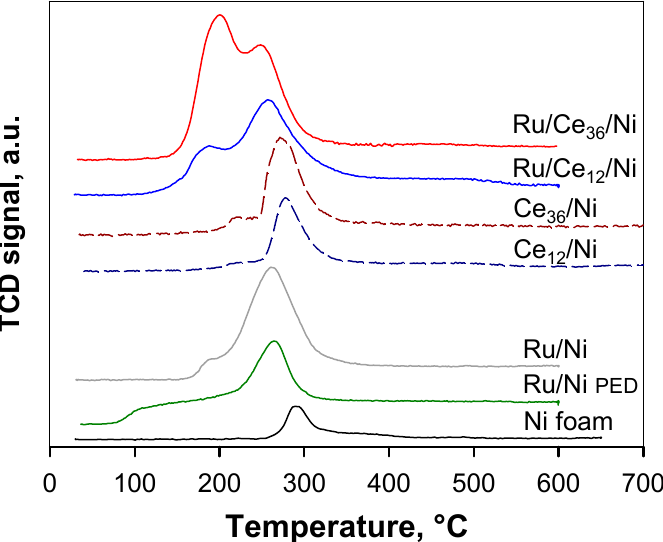
Figure 4. H 2 -TPR plots for Ru/Ni, Ce x /Ni and Ru/Ce x /Ni foam catalysts and their bare Ni support following a 1 h oxidative pretreatment in air at 300 °C.